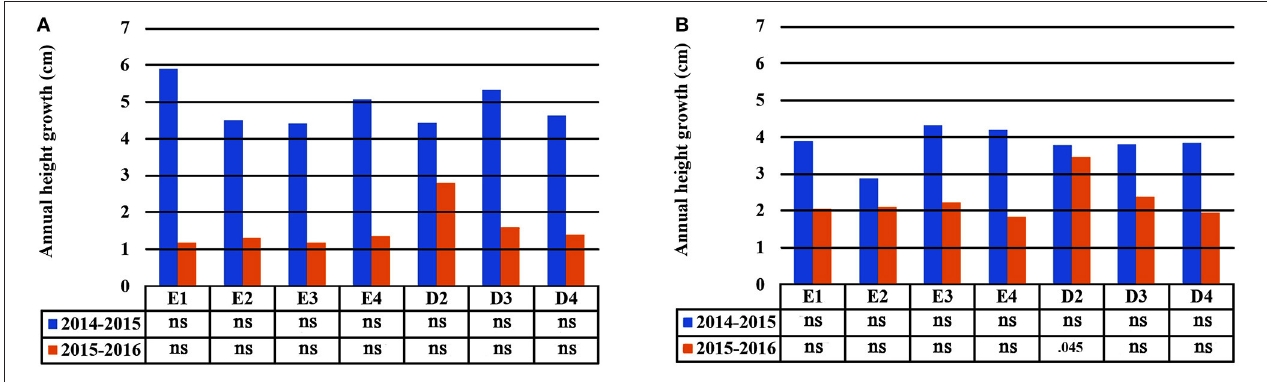
FIGURE 6 | Plastic response of populations in seedling height between consecutive years of the experiment under irrigation schemes A1 (A) and A2 (B) .